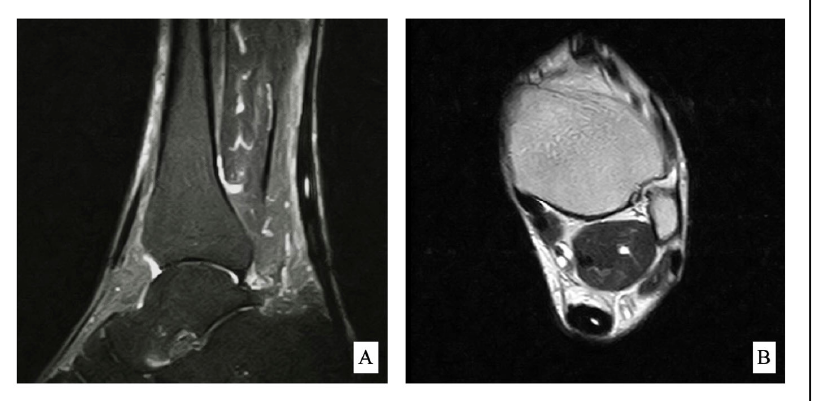
Figure 1. Sagi tt al fat-saturated ( A ) and axial T1 ( B ) show midportion Achilles